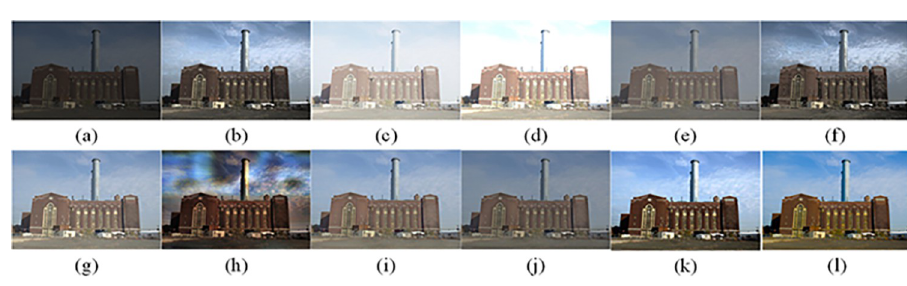
Fig 17. Comparisons of the ten algorithms in enhancing low-light image 7. (a) low-light image (b) AGCWD (c) Al- Ameen (d) BHE2PL (e) BIMEF (f) BPDHE (g) LIME (h) MSRCR (i) NPEA (j) SRIE (k) OURS (l) Normal light image.